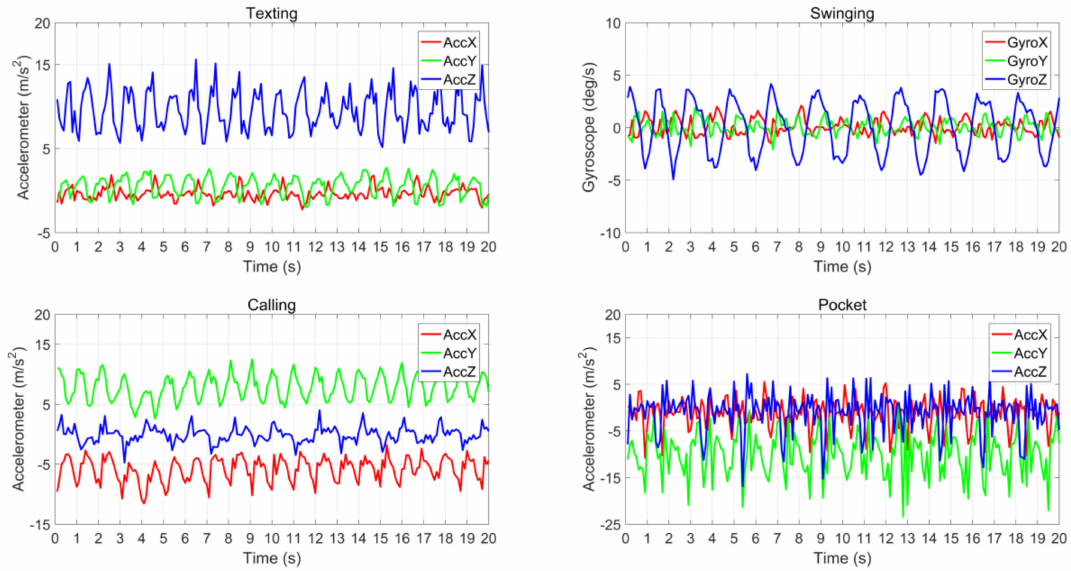
Figure 5. Internal sensors data in different